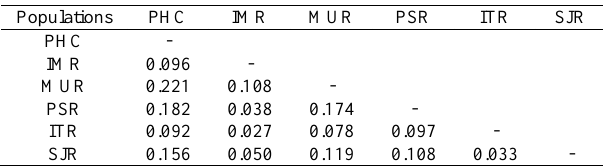
statistics (Slatkin, 1995) between Brycon Table 4. Pairwise R ST insignis populations based on five microsatellite loci . All pairwise p < 0.01. Power Company Hatchery (PCH), São João River (SJR), Paraíba do Sul River (PSR), Imbé River (IMR), Muriaé River (MUR) and Itabapoana River (ITR).